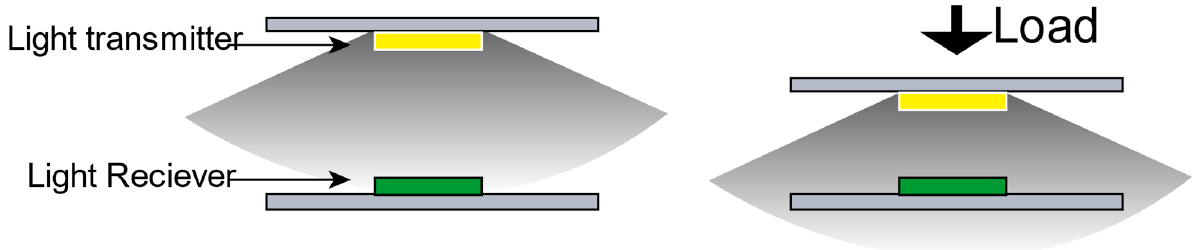
Figure 1. Photoelectric sensing principle diagram.